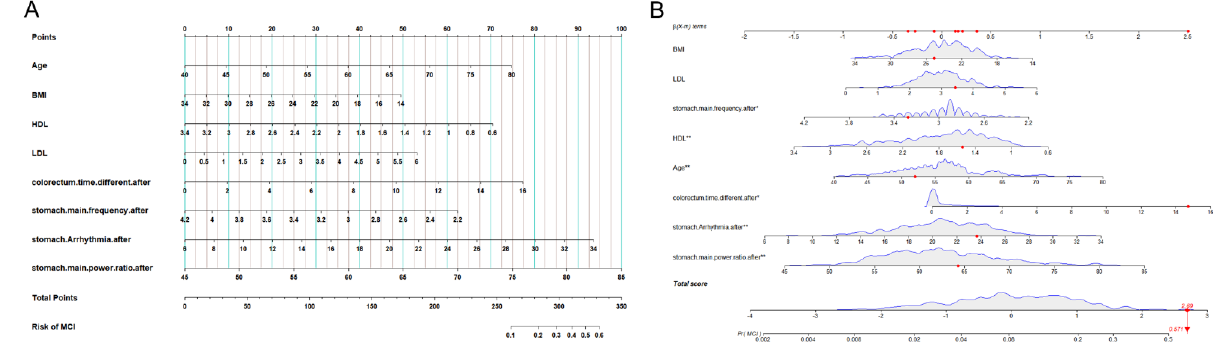
Figure 3. Development of the MCI risk nomogram in the training set ( A ) and in the validation set ( B ). The MCI risk nomogram was developed with the predictors age, BMI, HDL, LDL, TDIA, DFGA, RDGA, and DPGA. BMI, body mass index; HDL, high − density lipoprotein; LDL, low − density lipoprotein; TDIA, time difference of intestinal channel after meal; DFGA, dominant frequency of gastric channel after meal; RDGA, rhythm disturbance of gastric channel after meal; DPGA, dominant power ratio of gastric channel after meal. *: P<0.05, **: P<0.01.